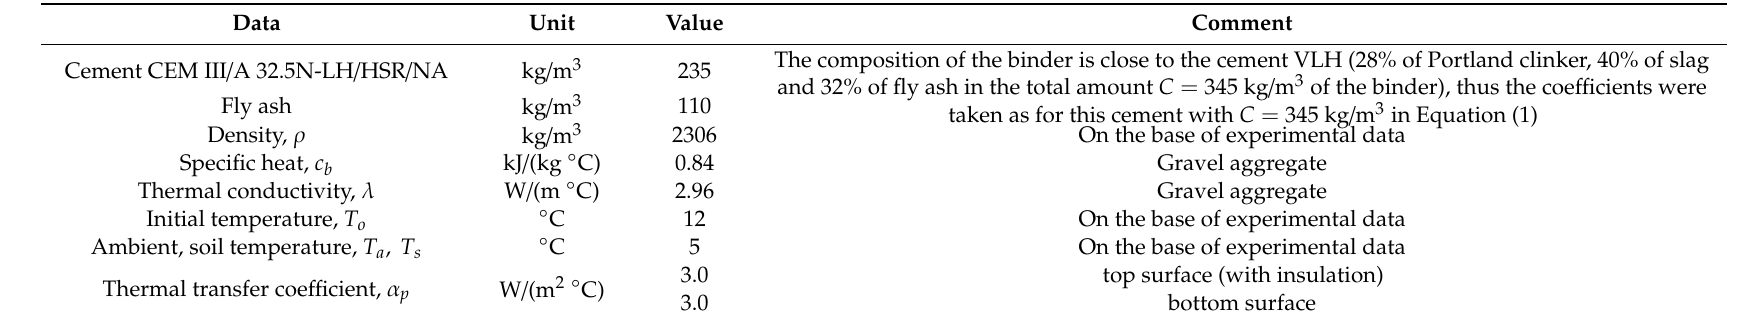
Table 11. Data for the experimental validation of the analytical